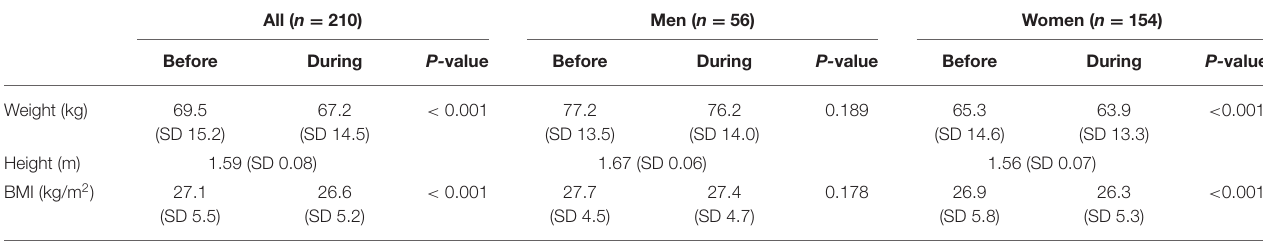
TABLE 7 | Weight changes and BMI before and during MCO among government servants during MCO. All ( n = 210) Men ( n = 56) Women ( n = 154) Before During P- value Before During P- value Before During P- value Weight